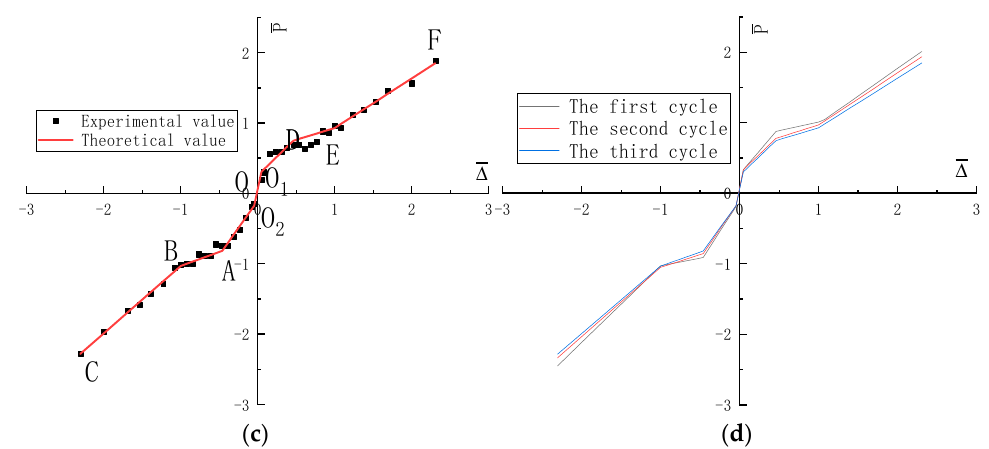
Figure 15. Fitting curves of the skeleton curves of the Kanchuang frame: ( a ) the first cycle; ( b ) the second cycle; ( c ) the third cycle; ( d ) fitting envelope curves of three cycles. Table 4. Coordinate critical points and ultimate loading points of the Kanchuang frame.